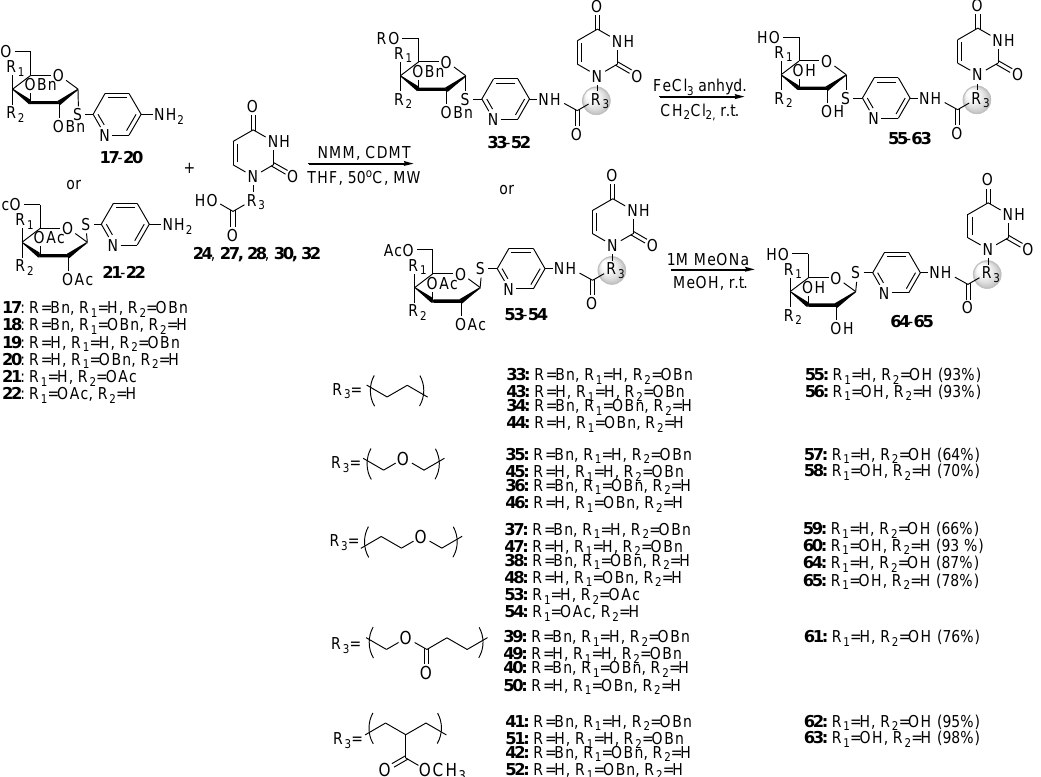
Scheme 5. Synthesis of glycoconjugates of acyclic uridine